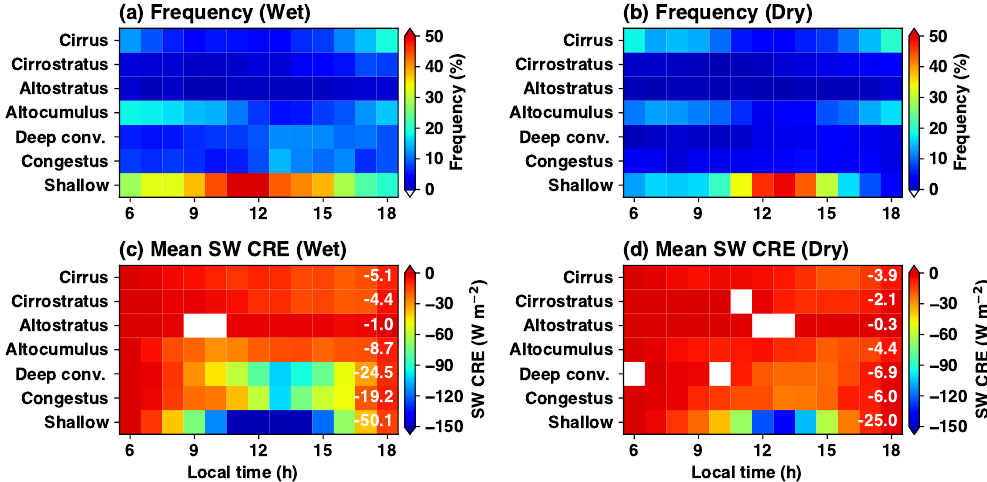
Figure 12. Wet (a, c) and dry (b, d) season comparisons for cloud frequency and SW CRE. (a, b) Cloud frequency of occurrence as the lowest cloud in the column, as a function of the diurnal cycle ( x axis). (c, d) Mean SW CRE (frequency of occurrence times the conditional SW CRE). The white numbers in panels (c, d) show the mean CRE values (in Wm − 2 ) averaged across the diurnal cycle (including nighttime). The white boxes represent hours with insufficient